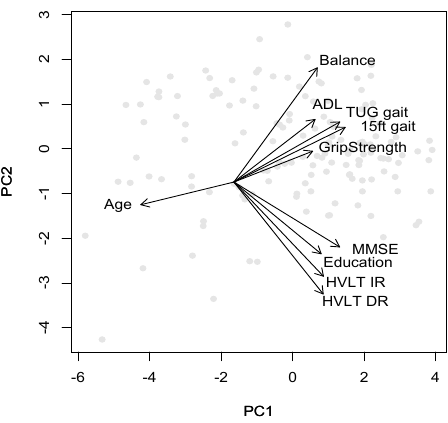
Figure 1. Mapping of the variables and participants (grey circles) onto the first 2 principal components.